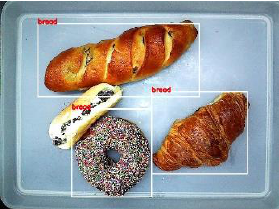
Table 1. The accuracy and speed of traditional detection and